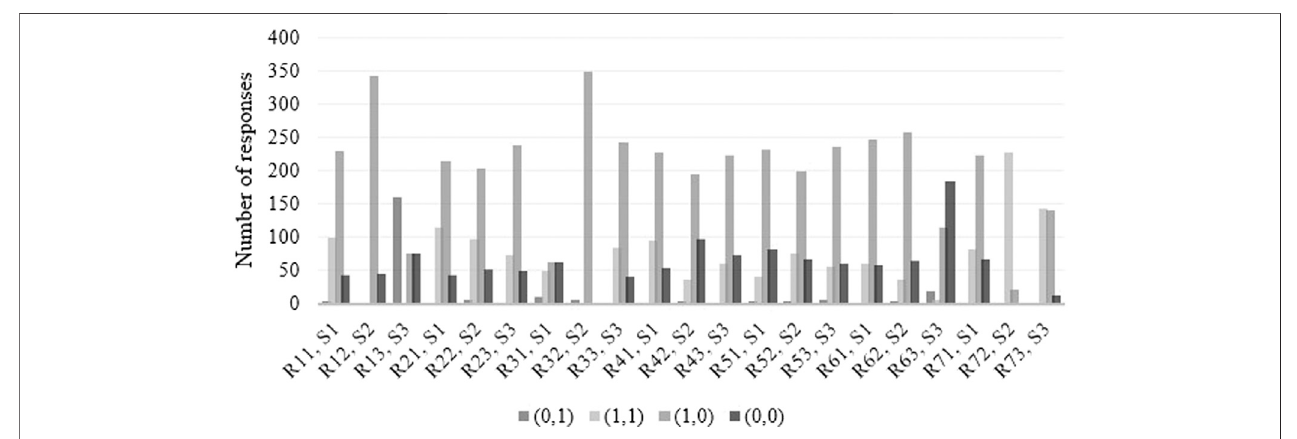
FIGURE 1 | Absolute frequencies for relational and social behavior variables.